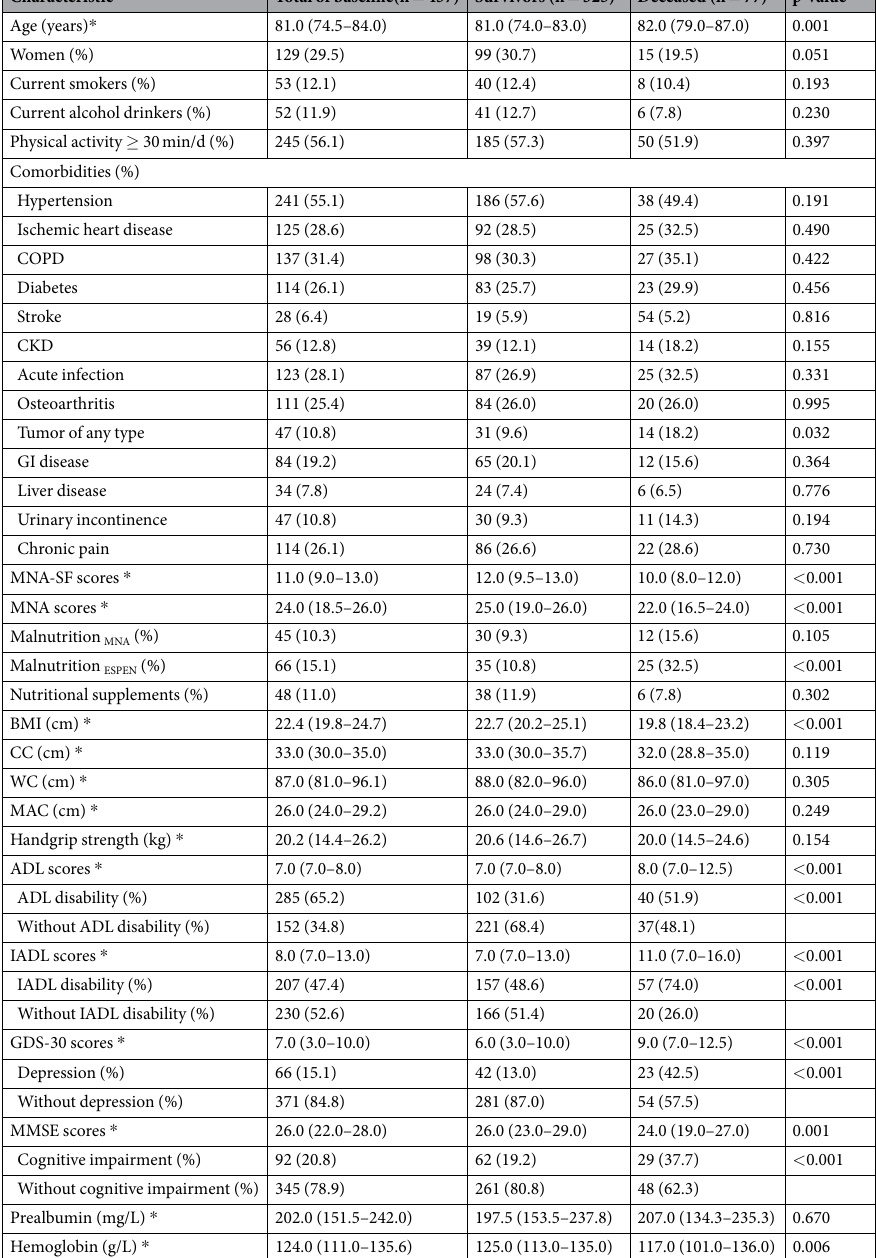
Table 1. Baseline characteristics of the whole study population and stratified by survivors and deceased at the end of a 3-year follow-up a . * Data are presented as median (IQR). a Thirty-seven participants lost follow-up during the 3-year period. The chi-square test was performed for categorical data and the Mann–Whitney’s U-test for continuous data with abnormal distribution. P < 0.05 was considered statistically significant. ADL: activities of daily living; BMI: body mass index; CC: calf circumference; CKD: chronic kidney disease; COPD: chronic obstructive pulmonary disease; GDS-30: 30-item Geriatric Depression Scale; GI: gastrointestinal; IADL: instrumental activities of daily living; IQR: interquartile range; MAC: mid-arm circumference; MMSE: Mini- Mental Status Examination; MNA-SF: Mini Nutritional Assessment Short-Form; WC: waist